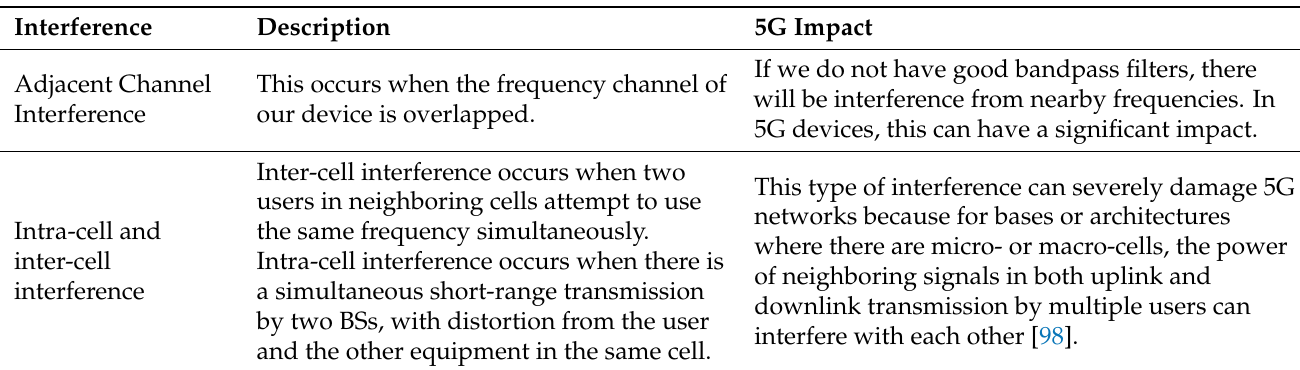
Table 8. Technologies for the